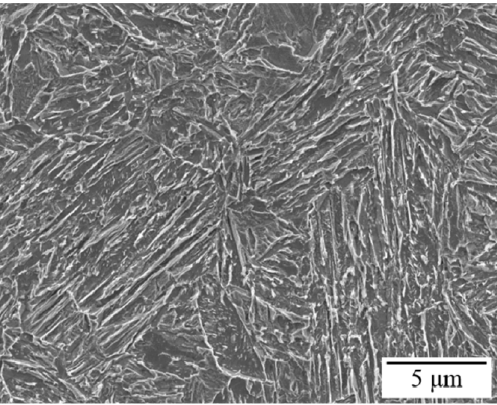
Figure 5. SEM micrograph of a 0.2 C, 3 Mn, 1.6 Si (wt. pct.) steel processed by quenching and partitioning after full austenitization [18]. (Nital etch; secondary electron image).